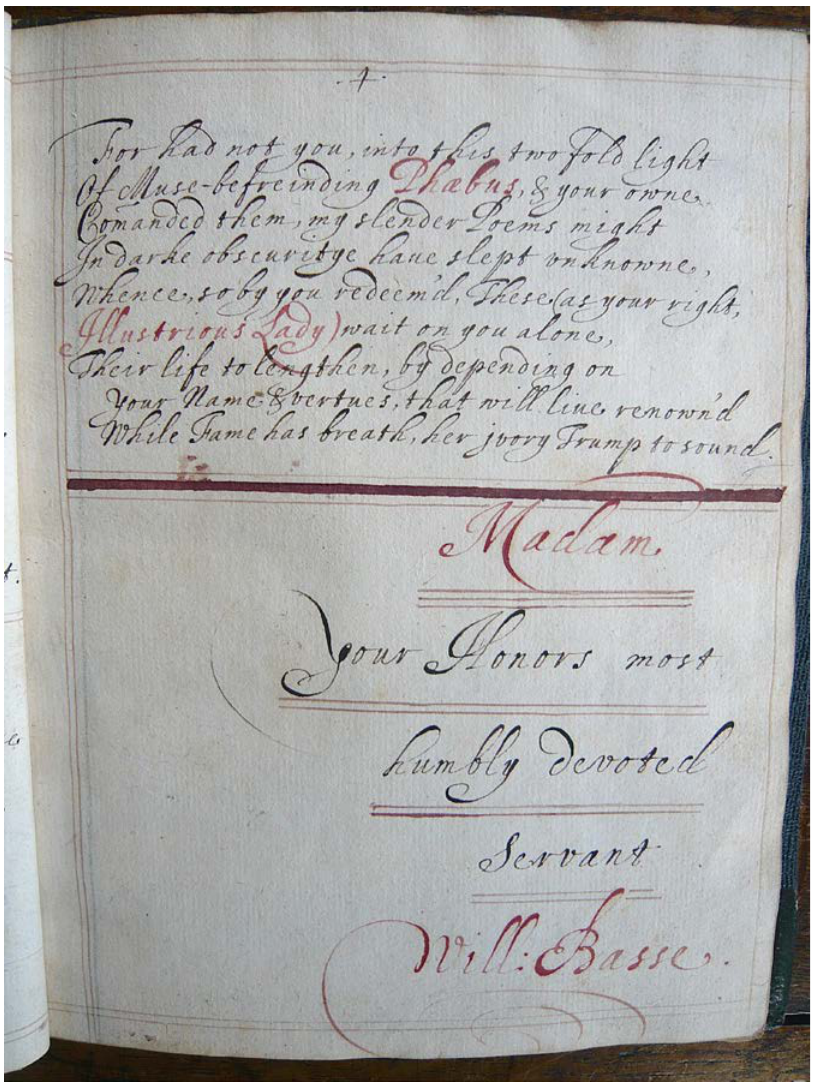
Fig. 3 - Subscription of the collection’s opening poem to Bridget Bertie, countess of Lindsey, f.